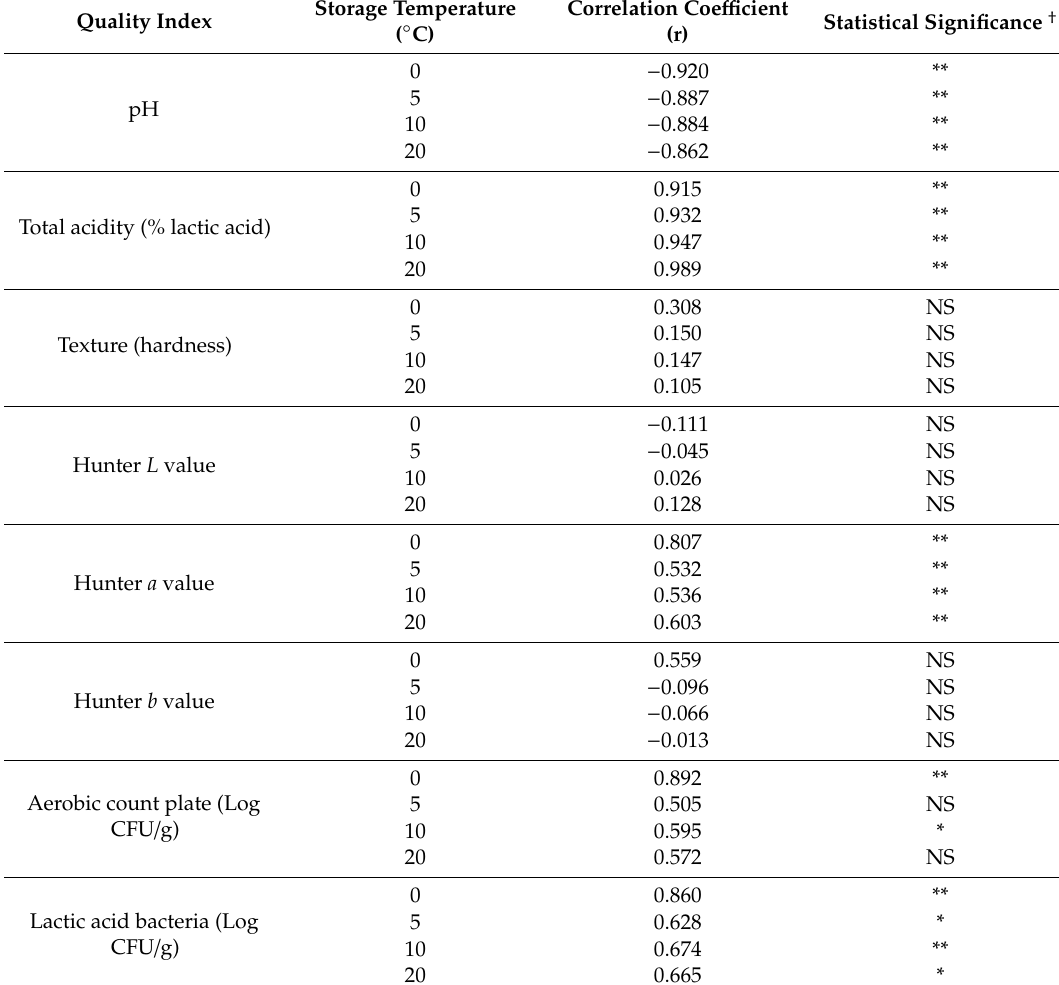
Table 2. Pearson correlation coe ffi cients between overall ripeness and quality index of